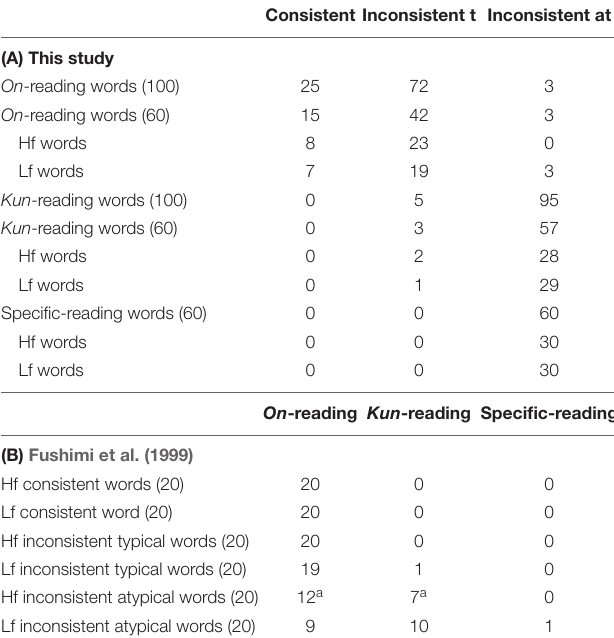
TABLE 2 | Numbers of reading-type